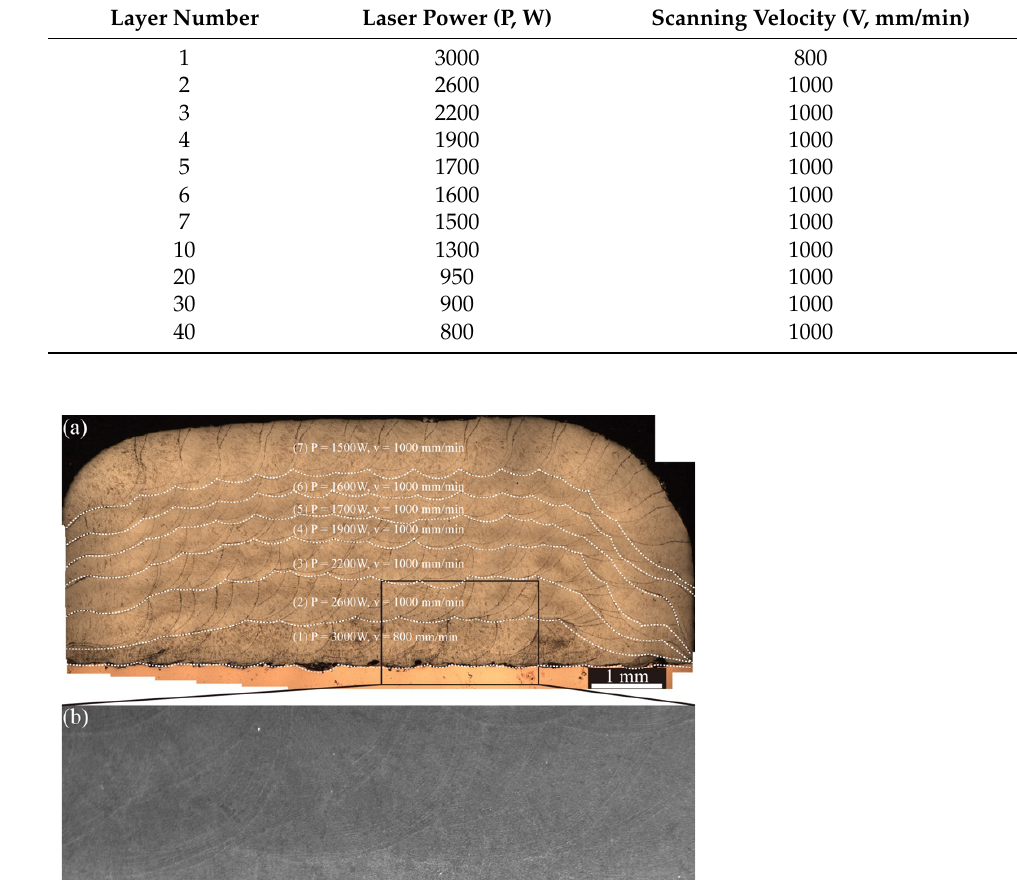
Table 4. Processing parameters used for the seven-layer and bulk specimen.